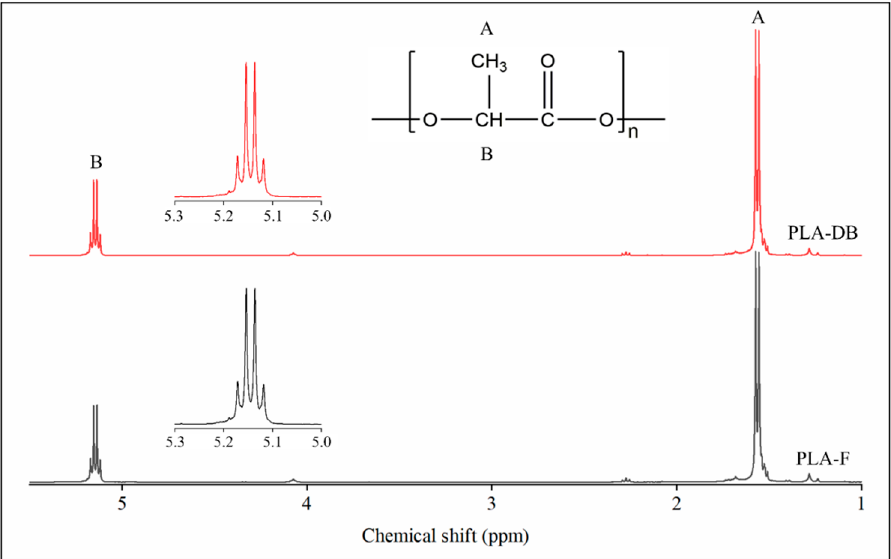
Figure 7. 1 H-NMR spectroscopy: spectra of the filament PLA-F (black) and the dog-bone-shaped sample PLA-DB (red).